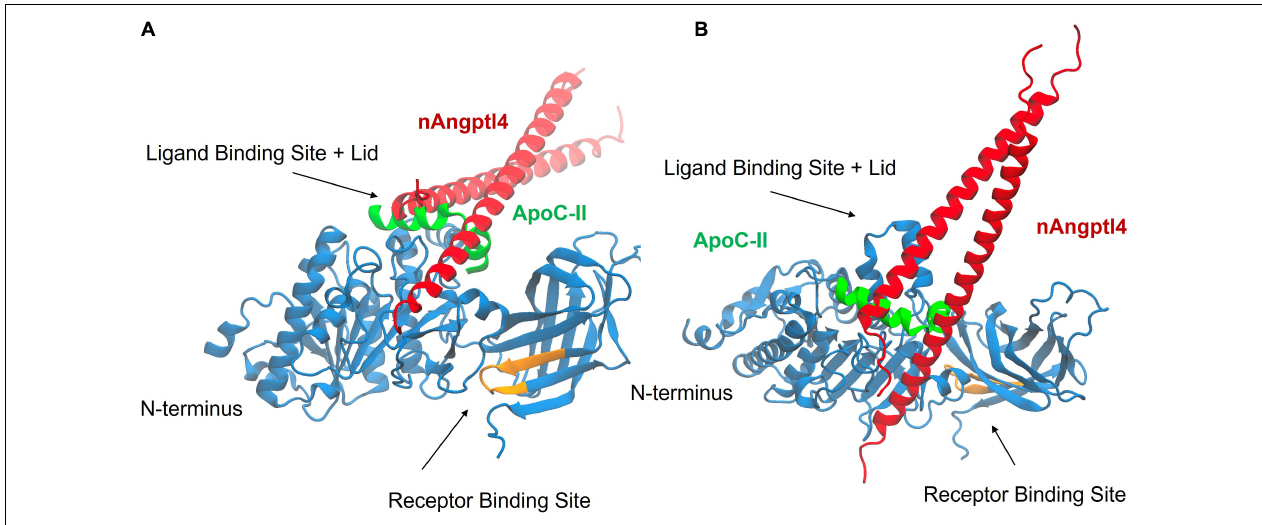
FIGURE 6 | Results from molecular docking of LPL (blue) with the synthetic ApoC-II peptide (green), and nAngptl4 fragment (red) used in the experimental protocol, showing the top HDOCK-scored complex from both a front view (A) and top view (B) . The receptor binding site of LPL is highlighted in orange. The results show that the ApoC-II peptide and nAngptl4 fragments are expected to bind to the ligand binding site and lid domain of LPL, consistent with our experimental